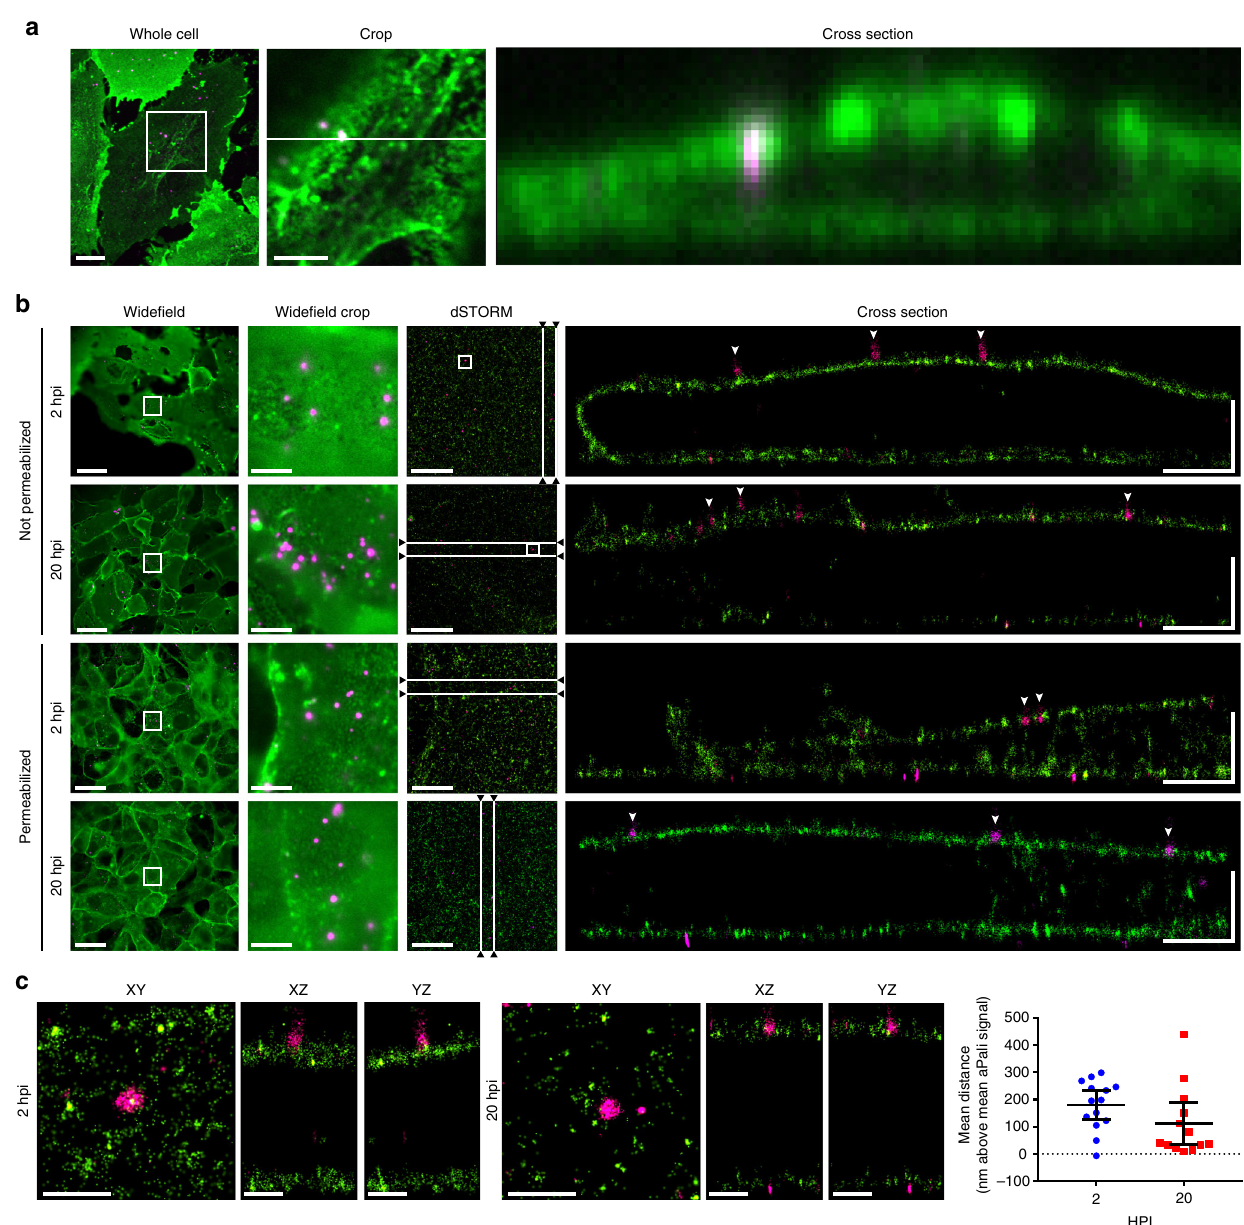
Fig. 2 Mechanism of action of aPali by super-resolution microscopy. a Vero cells were transfected with 1 μ g of aPali and infected with RSV at MOI of 1. At 24 hpi, cells were fi xed, stained with anti-human secondary (green) and for RSV N (magenta) and imaged using a confocal microscope. Cropped image is a magni fi cation of white box inset. Cross section is along the white line in the cropped image. Scale bar in whole cell represents 10 μ m, while scale bar in cropped image represents 5 μ m. b The same cells from part ( a ) were imaged using 3D dSTORM. Cells were fi xed at either 2 or 20 hpi and permeabilized or not, as indicated. Wide fi eld reference images were captured on the same microscope immediately prior to acquisition, with the cropped region indicating magni fi cation of the white box. dSTORM images were acquired on the wide fi eld cropped region. Cross section views are shown from a 2 μ m slice through the XY image as indicated by the white lines. Arrowheads indicate single RSV virions. Scale bar in the wide fi eld images represent 20 μ m, while scale bars in the wide fi eld crop and dSTORM images represent 5 μ m. Scale bar “ L ” represents 2 μ m in both directions. c Single RSV particles were cropped from white boxes in the dSTORM images from unpermeabilized cells in part ( b ). XY views, as well as XZ and YZ are shown. Scale bars represent 700 nm. A 1 μ m square ROI was centered on individual viral particles and the mean distance in the z direction between the aPali and RSV N signals per particle were determined at 2 and 20 hpi ( n = 13). Error bars represent 95% percent con fi dence interval. No signi fi cant difference was found, p > 0.05 (Mann – Whitney U Test). Results represent mean of two independent